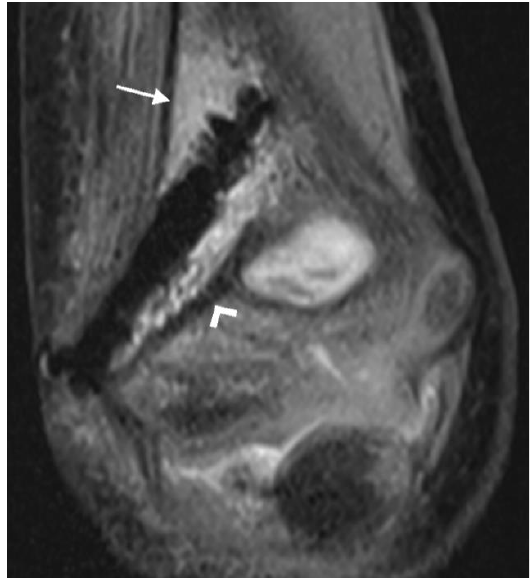
Figure 3. PD tse fs (proton density turbo spin echo fat-saturated) coronal image of the left elbow of a 7-year-old boy with a lateral humeral condyle fracture. Bone marrow edema is seen as a hyperintense signal in the bone marrow (arrow). Hypointense gas locules are also visible along the screw. A second, smaller magnesium screw is visible in the distal part of the humerus (arrowhead).